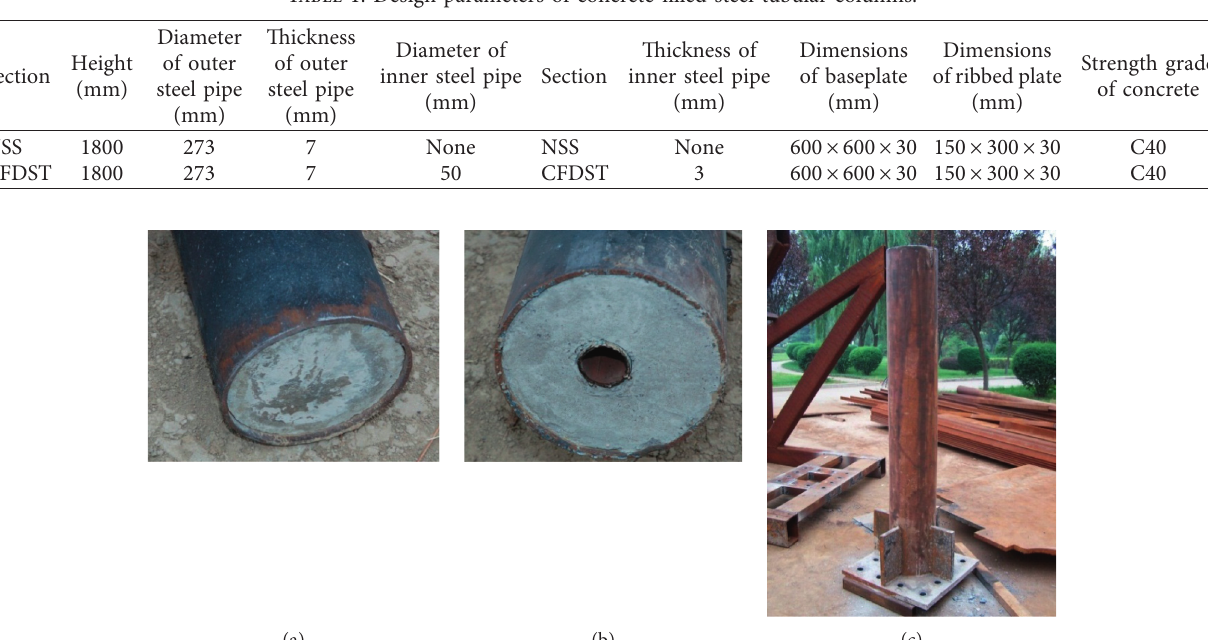
Figure 1: Cross sections of columns. (a) NSS. (b) CFDST section. Table 1: Design parameters of concrete-filled steel tubular columns.